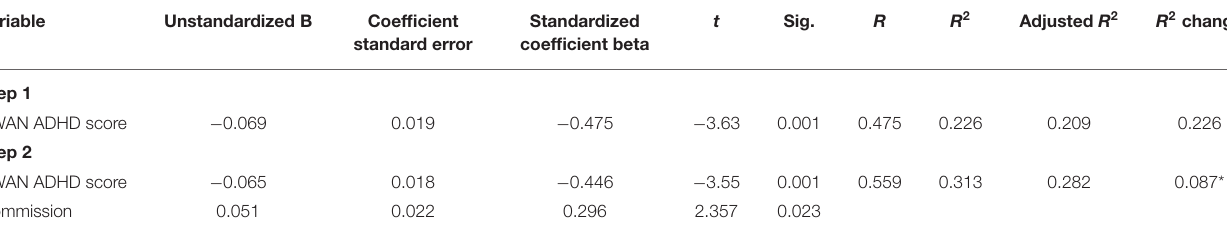
TABLE 11 | Regression model of the CCPT measures as the predictors of the CBCL social problem subscale score in the control group.